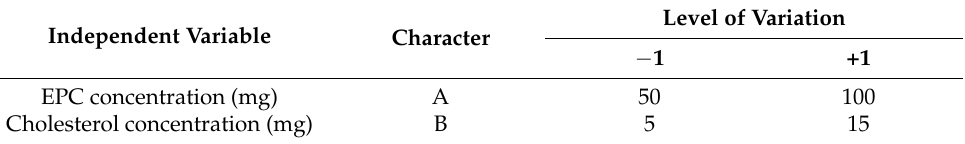
Table 5. CCD data showing independent variables and their level of variation. Independent